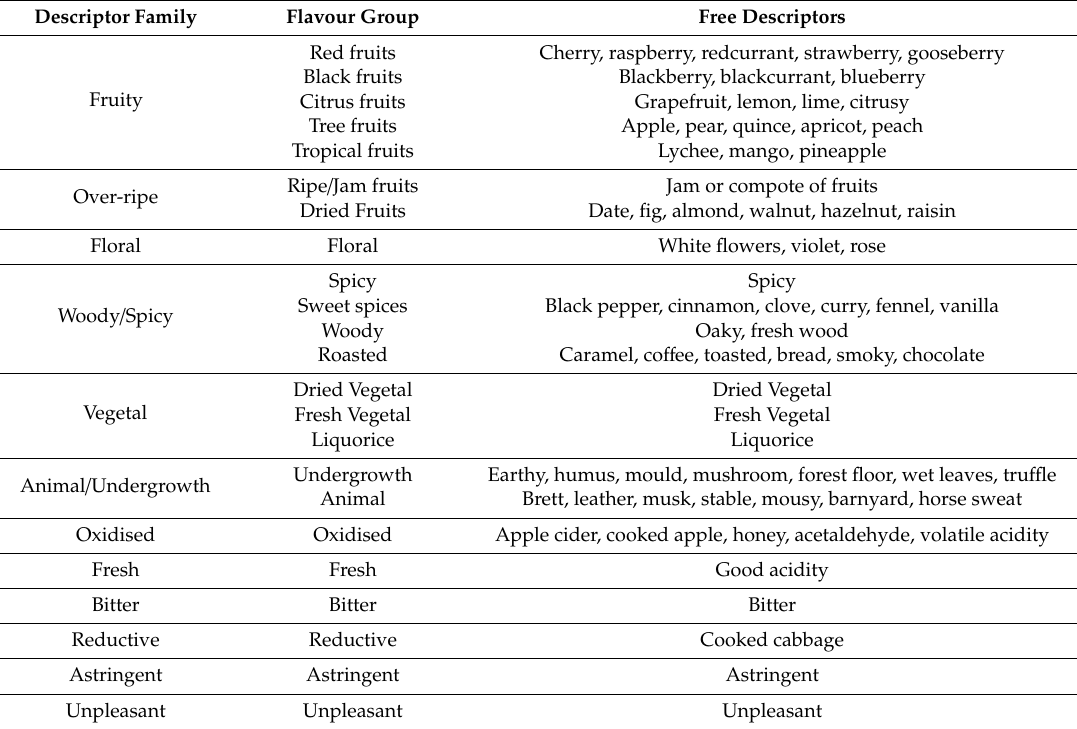
Table 6. List of free sensory descriptors gathered in 12 overall families of flavor